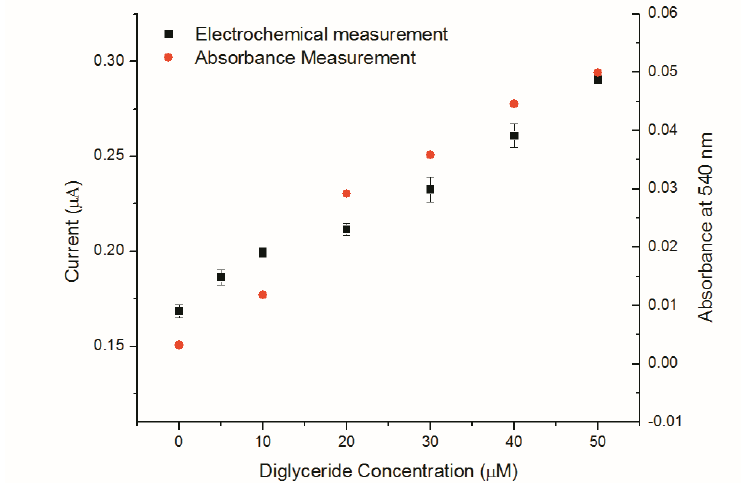
Figure 13. Comparison of 1:1: bovine serum-buffer samples containing DG measure by sepctrophotometry and the proposed single-use